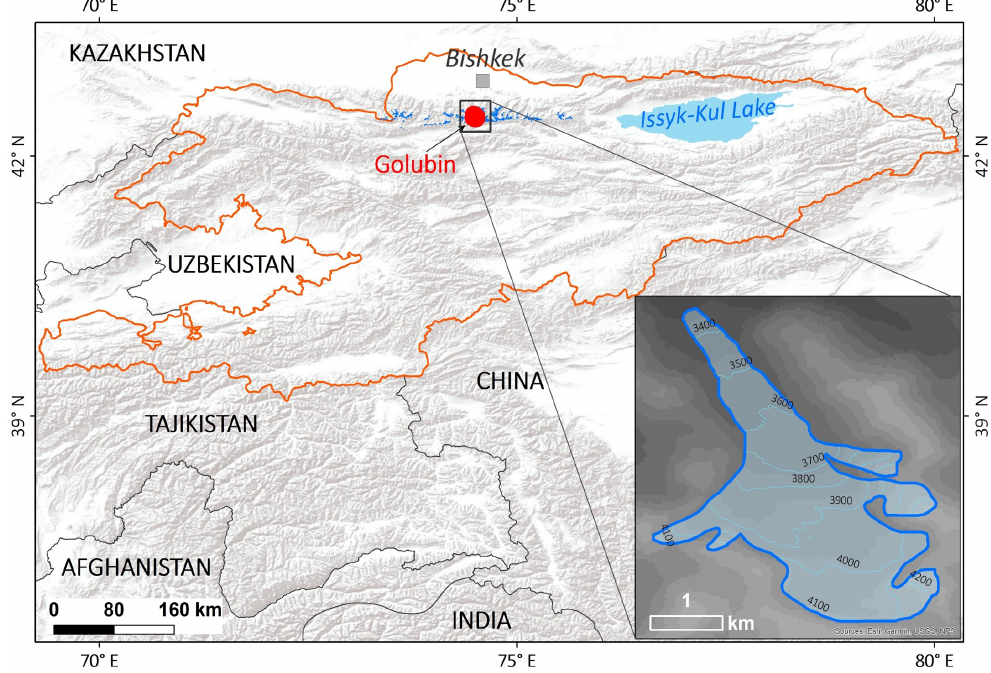
Figure 1. Location of the study area. Inset shows a topographic map of Golubin